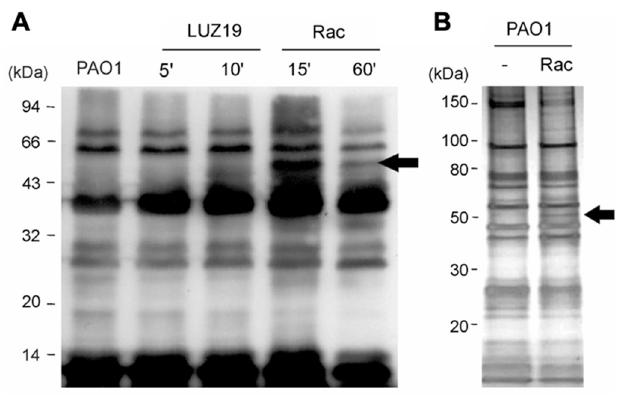
Figure 3. Impact of LUZ19 infection and Rac expression on P. aeruginosa PAO1 acetylation. ( A ) Variation in the P. aeruginosa acetylome upon infection of LUZ19 and induction of Rac expression. In each lane, 150 µg of cytoplasmic soluble proteins were separated by SDS-PAGE, transferred to a PVDF membrane and subjected to anti-acetyl lysine Western blot. ( B ) SDS-PAGE gel showing the result of an immunoaffinity enrichment of the Rac substrates from P. aeruginosa cell lysate. The arrow indicates the additional acetylated protein in the presence of recombinant Rac and acetyl-CoA in comparison to the control sample.